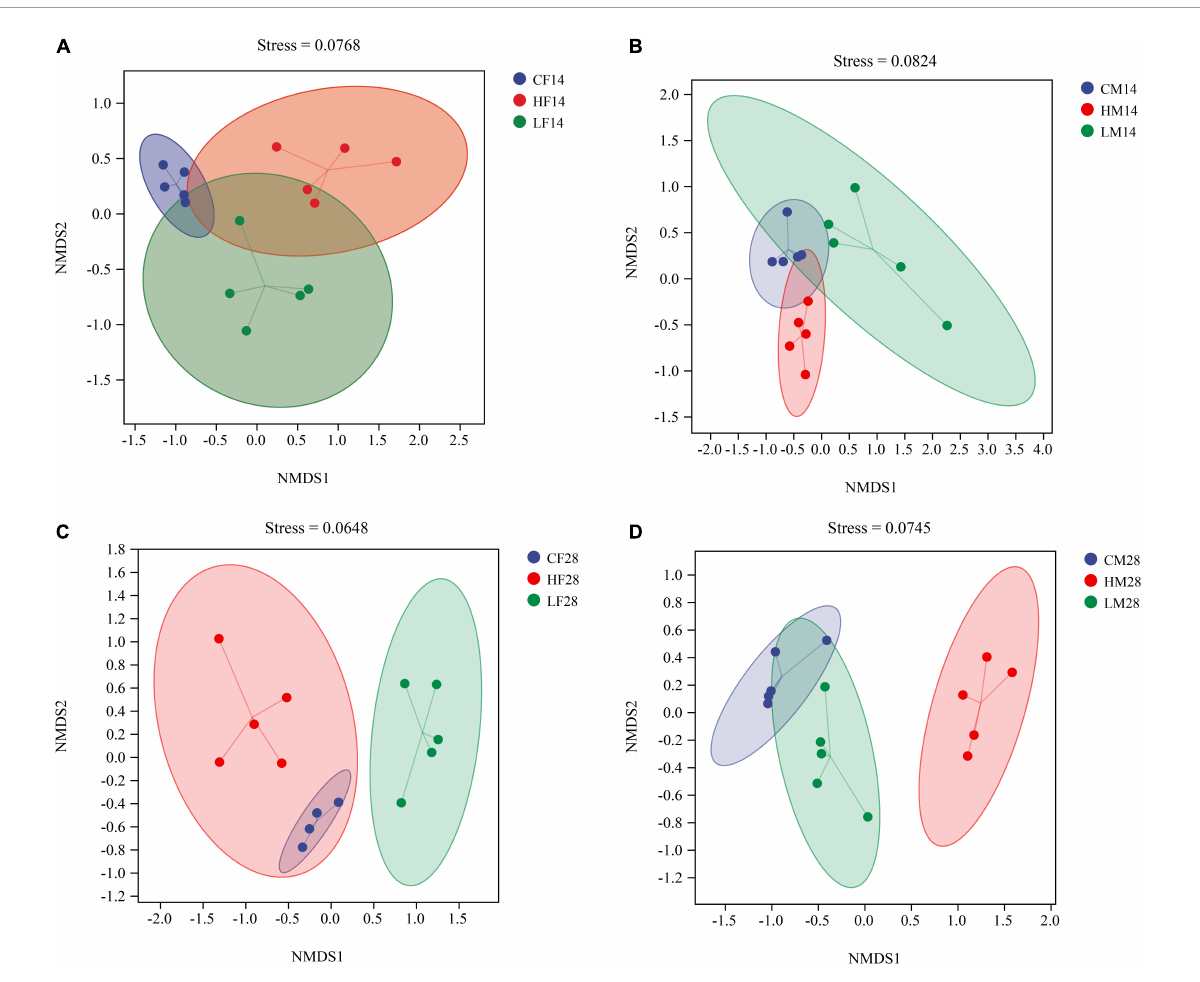
FIGURE6 Non-metric multidimensional scaling (NMDS) analysis based on Bray-Curtis distances plots of Pomacea canaliculata intestine microbial communities at the different temperature [ (A) 14 days female; (B) 14 days male; (C) 28 days female; (D) 28 days